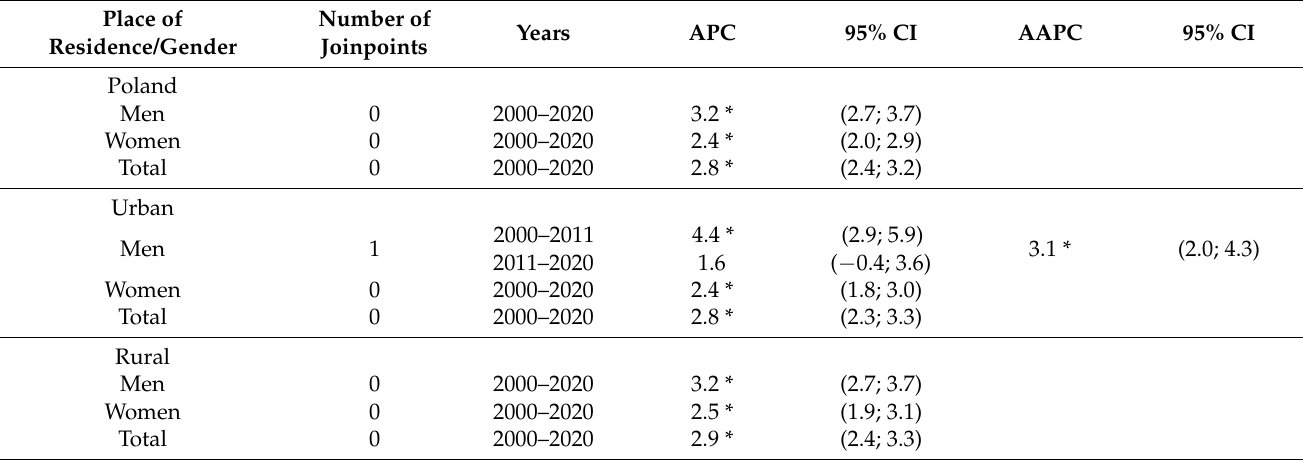
Table 6. Time trends of CDR due to skin melanoma by gender and place of residence in Poland in 2000–2020—results of joint regression